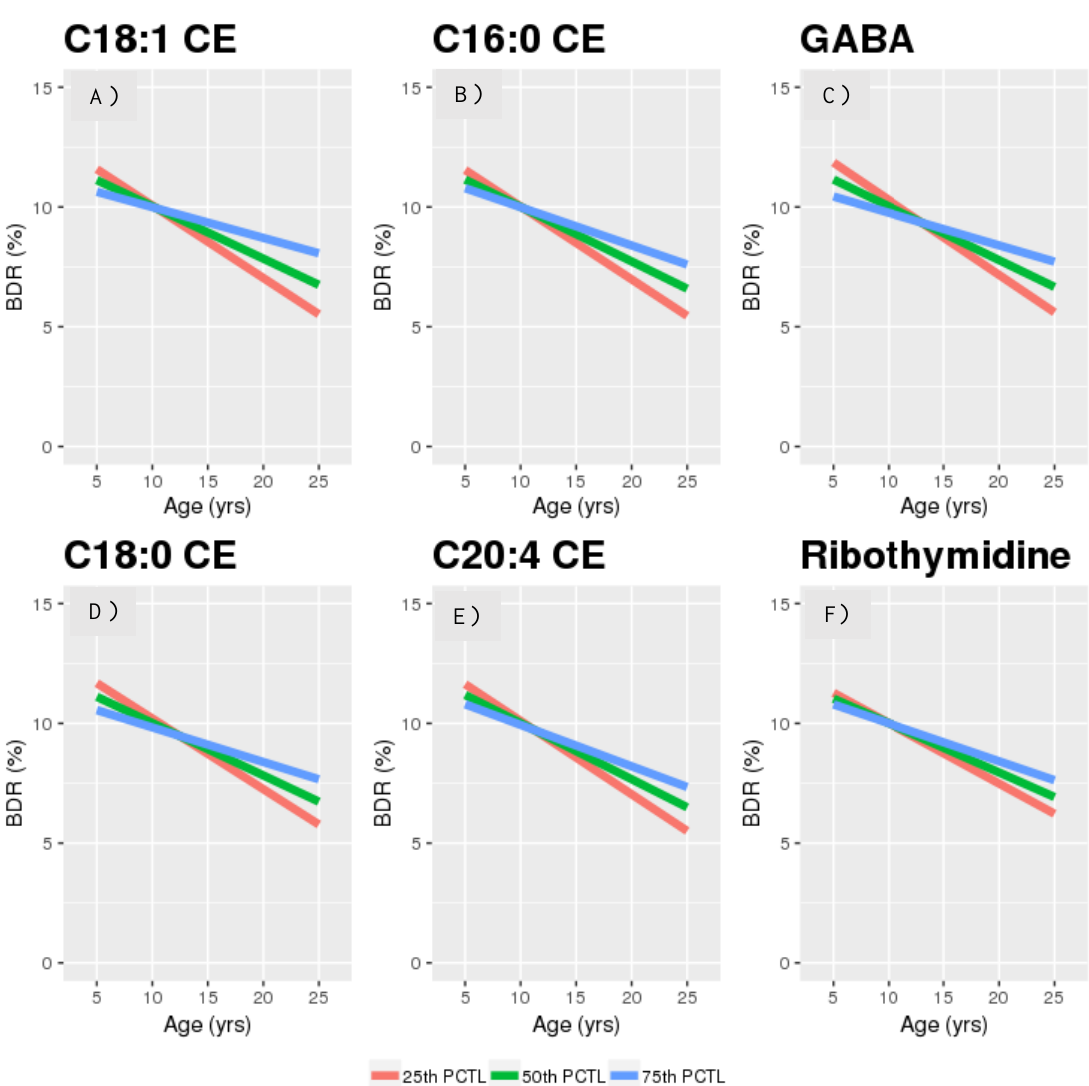
Figure 2. ( A ) C18:1 CE; ( B ) C16:0 CE; ( C ) GABA; ( D ) C18:0 CE; ( E ) C20:4 CE; ( F ) Ribothymidine in CAMP (25th, 50th, and 75th percentiles). Abbreviations: PCTL — percentile; CE — cholesterol ester GABA — gamma-aminobutyric acid.